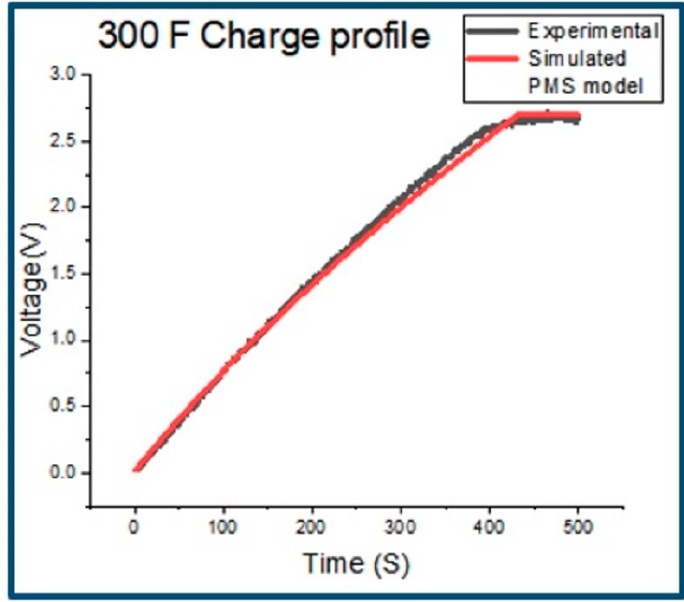
Figure 9. The 300 F EDLC superimposed experimental/PMS-charge profile.